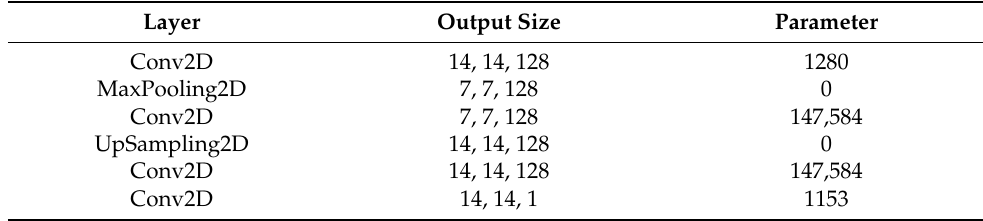
Table 1. Architecture of Convolutional